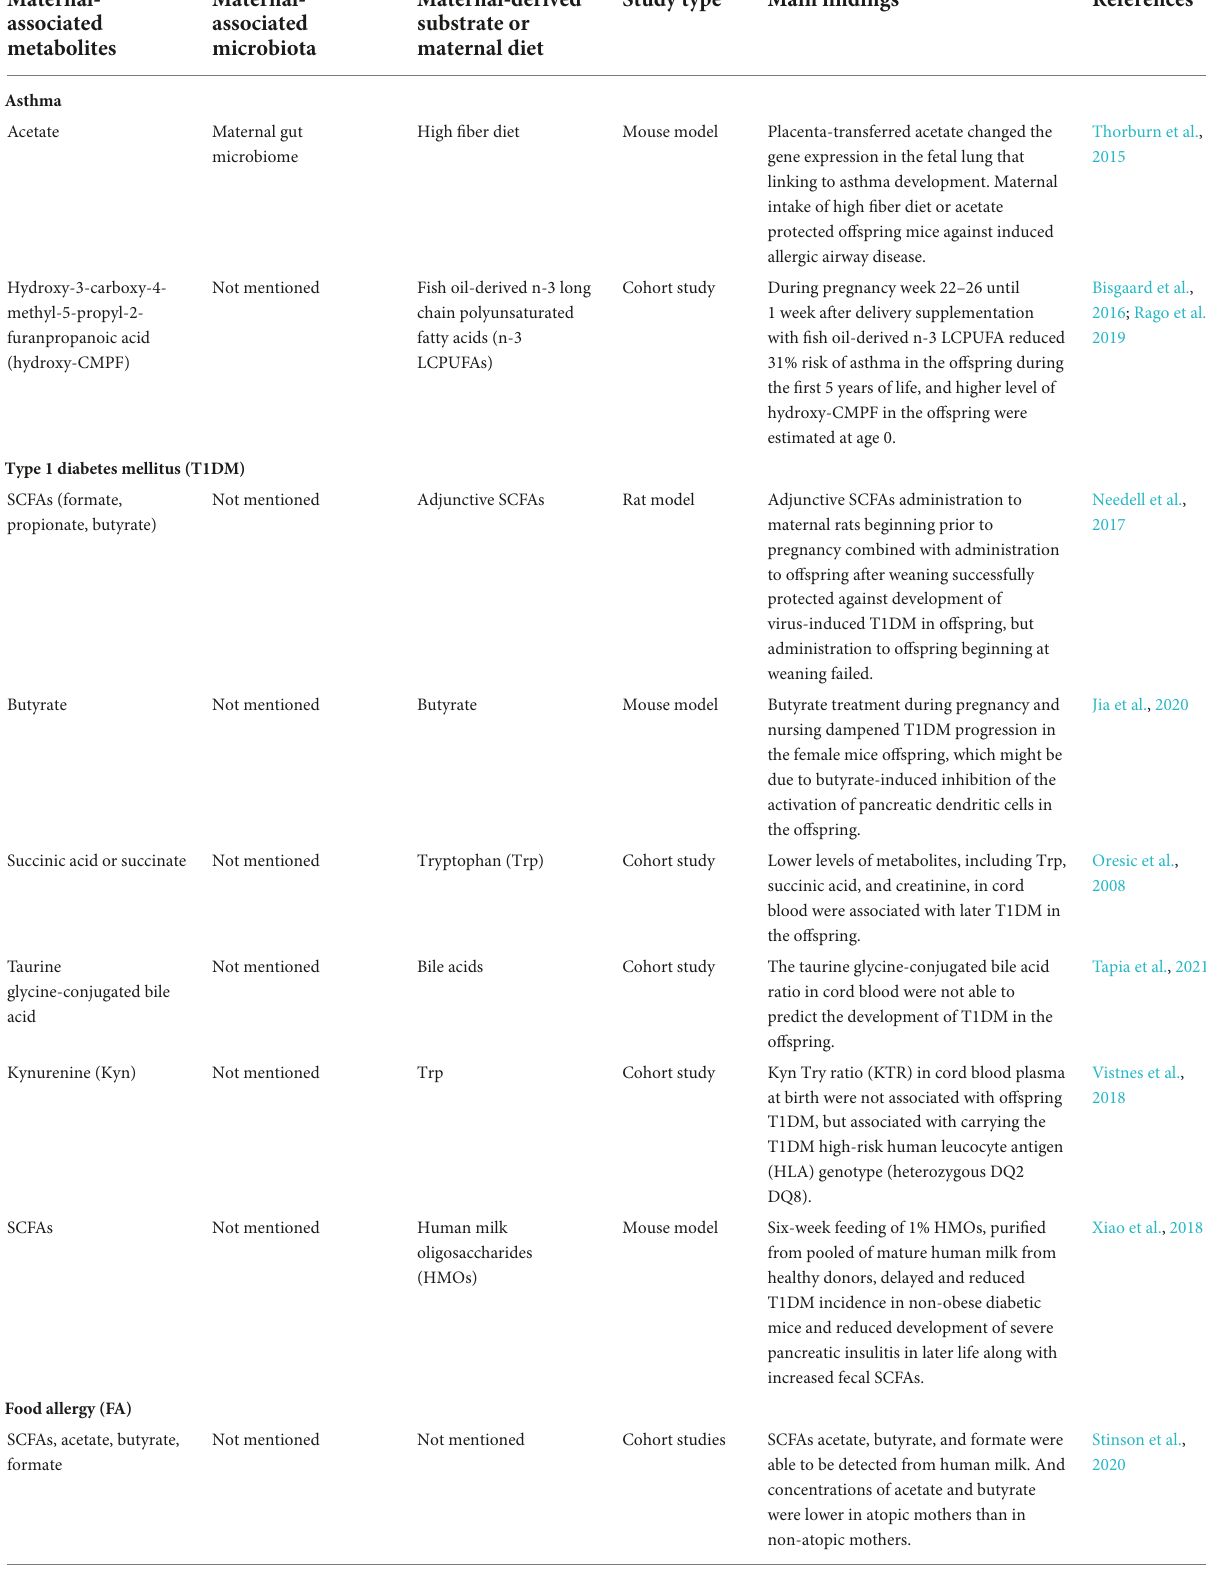
TABLE 1 Main results of maternal-associated microbial metabolites and offspring diseases mentioned in this review. Maternal-